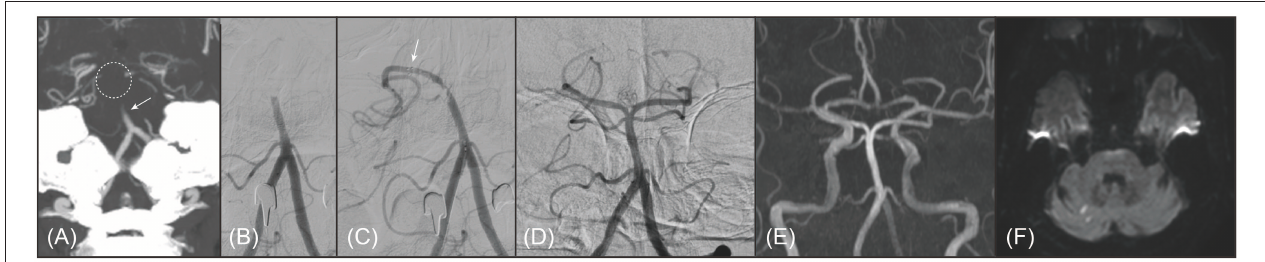
FIGURE 1 | A representative example of 67-year old male patient with branching-site occlusion. (A,B) Basilar artery (BA) occlusion was noted on preprocedural computed tomography angiography ( A , coronal view of maximal intensity projection image; arrow) and digital subtraction angiography ( B , anteroposterior view). BA bifurcation site was not clearly seen on preprocedural computed tomography angiography (dotted circle). (C) Post-deployment angiogram showed only unilateral posterior cerebral artery was observed, which could be considered as a finding of branching-site occlusion (branch-missing sign). Distal marker of the stent retriever was seen on the angiogram (arrow). (D) With 1 stent retriever thrombectomy, the BA was completely recanalized. (E) On follow-up magnetic resonance angiography (time-of-flight image) performed 1 day after procedure, the recanalized BA was patent. (F) Only multiple tiny acute infarctions were noted in bilateral cerebellum and